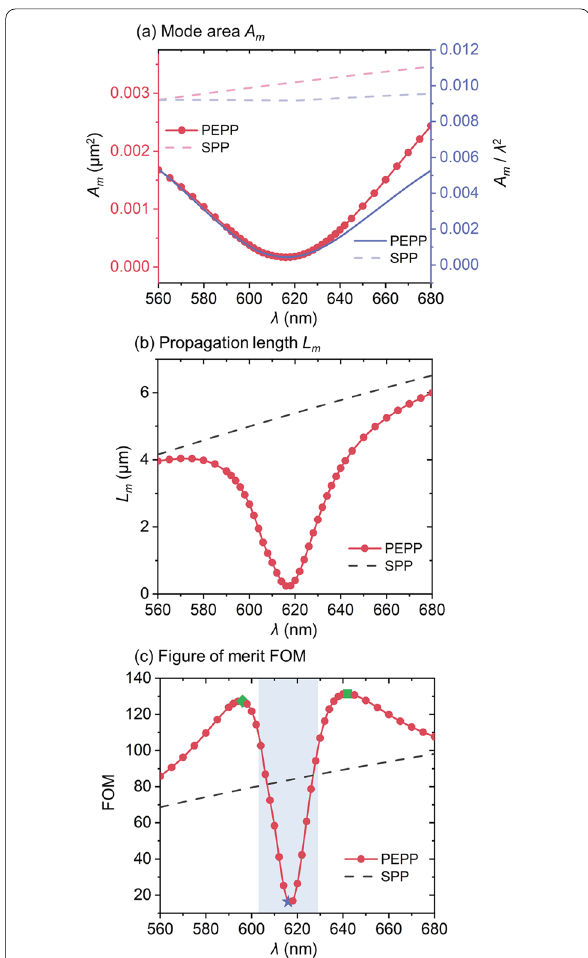
Fig. 4 Waveguiding properties including a mode area A m (left y -axis) and normalized mode area A m / λ 2 (right y -axis), b propagation length L m , and c figure of merit (FOM) of the PEPP and SPP with a MNW diameter of 50 nm. Compared to the monotonic behaviors of the SPP, the PEPP is able to exert its full strength for energy confinement in the exciton-like region (blue-filling area in c ), while is capable of achieving excellent FOM in the SPP-like region (non-filling area in c ). Blue star: maximum confinement. Green diamond and square: local maximum FOMs. The diameter for the Ag MNW here is 50